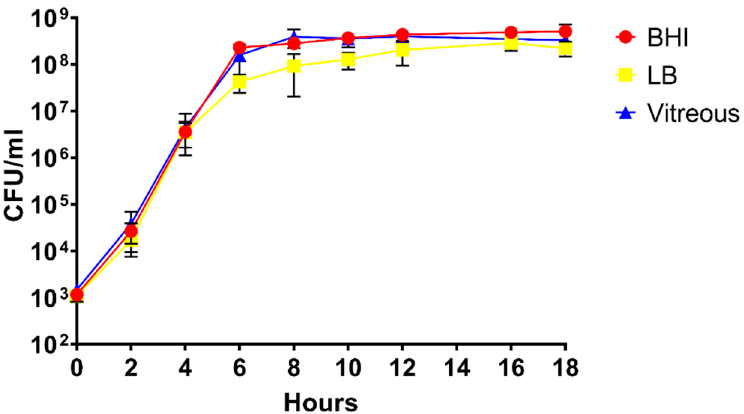
Figure 1. Analysis of the growth of B. cereus in Brain Heart Infusion (BHI), Luria Bertani (LB), or rabbit vitreous. In vitro growth curves of B. cereus in the three different environments. CFU/mL at each time point was similar in BHI, LB, and rabbit vitreous. The values shown represent the combined results of two separate growth analysis experiments using independent batches of BHI, LB, or rabbit vitreous, with n = 3 independent cultures in each environment per experiment for a total of 6 biological replicates per time point. Values are the mean of the six replicates ± SD.